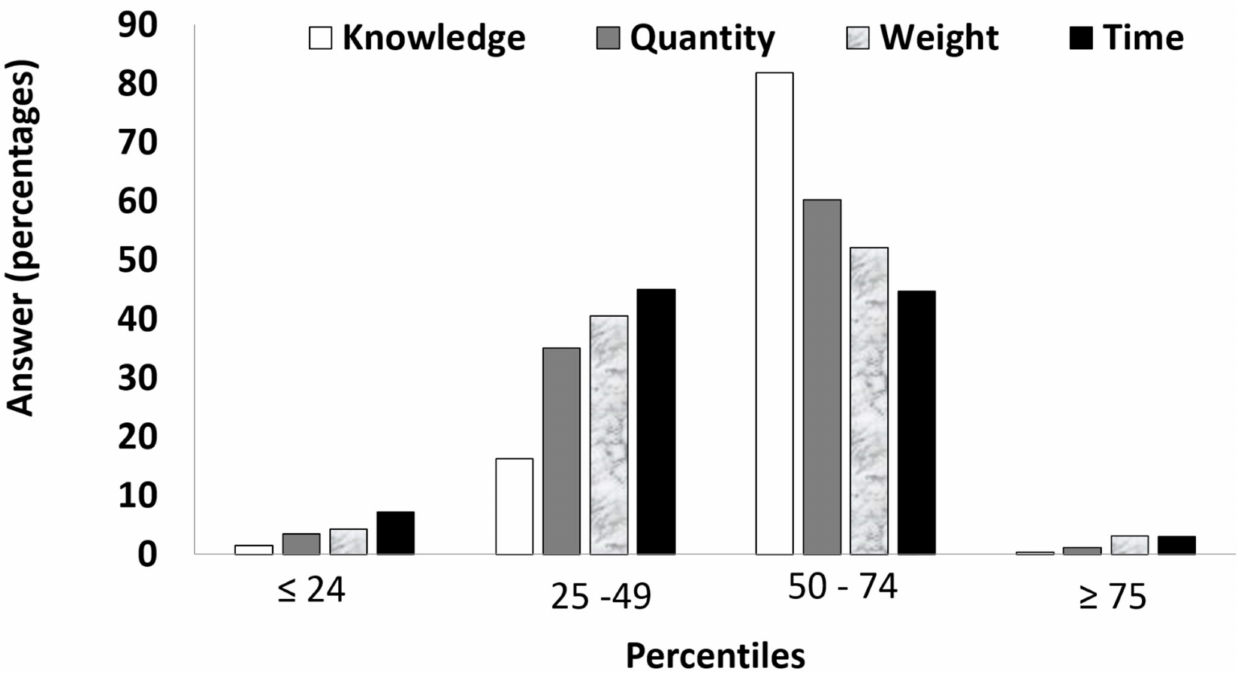
Figure 2. Percentiles of responses by category and answer.